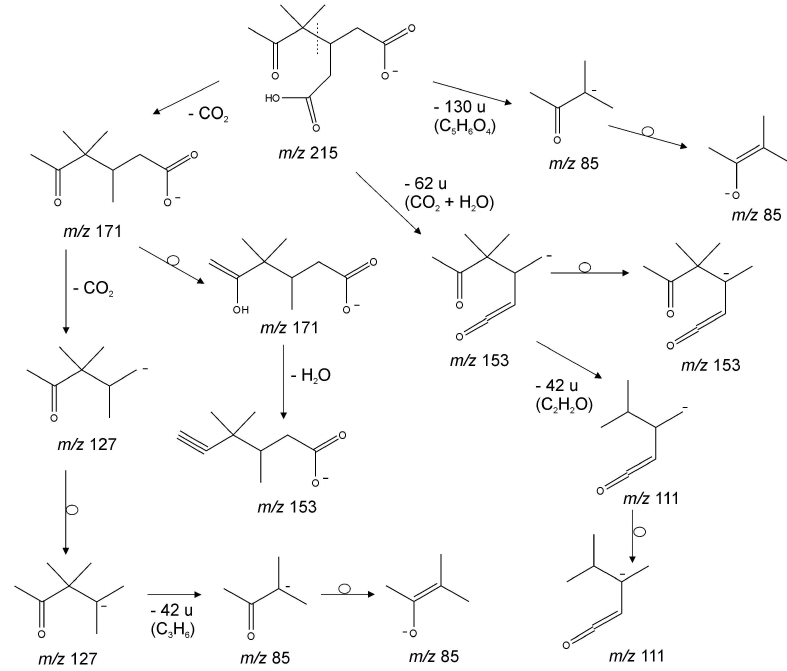
Fig. 11. Proposed structure of the m / z 215 compound and its fragmentation